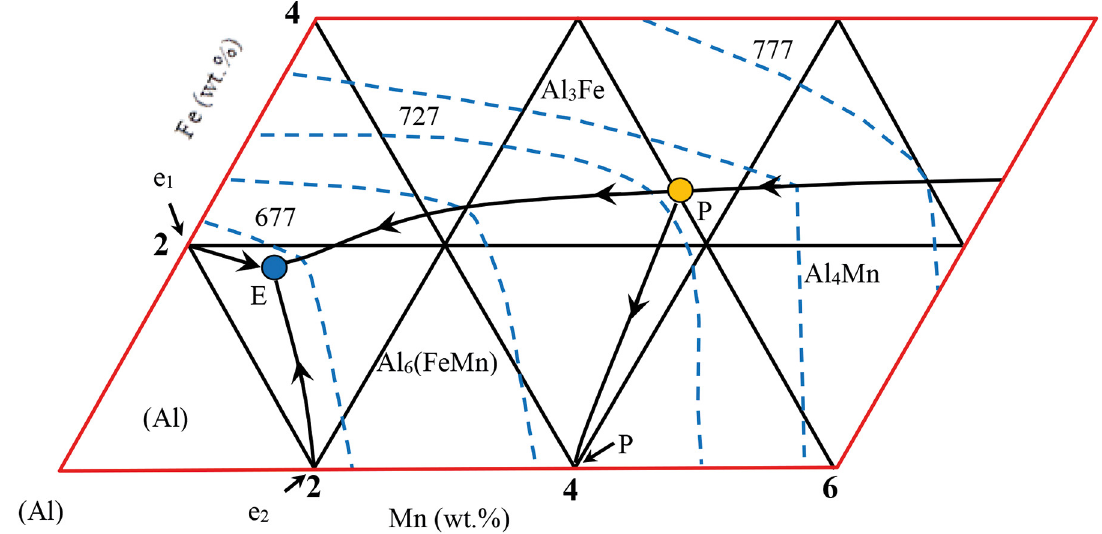
Fig. 1. Al-rich corner of the ternary Al–Mn–Fe phase diagram adopted from ref.